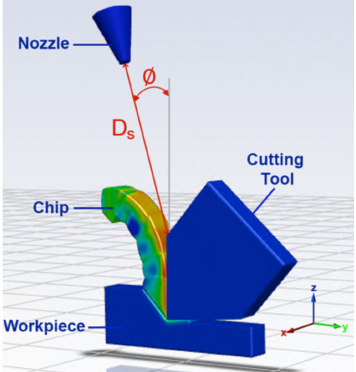
Figure 2. Tool–chip geometry showing the varied parameters, D s and ∅